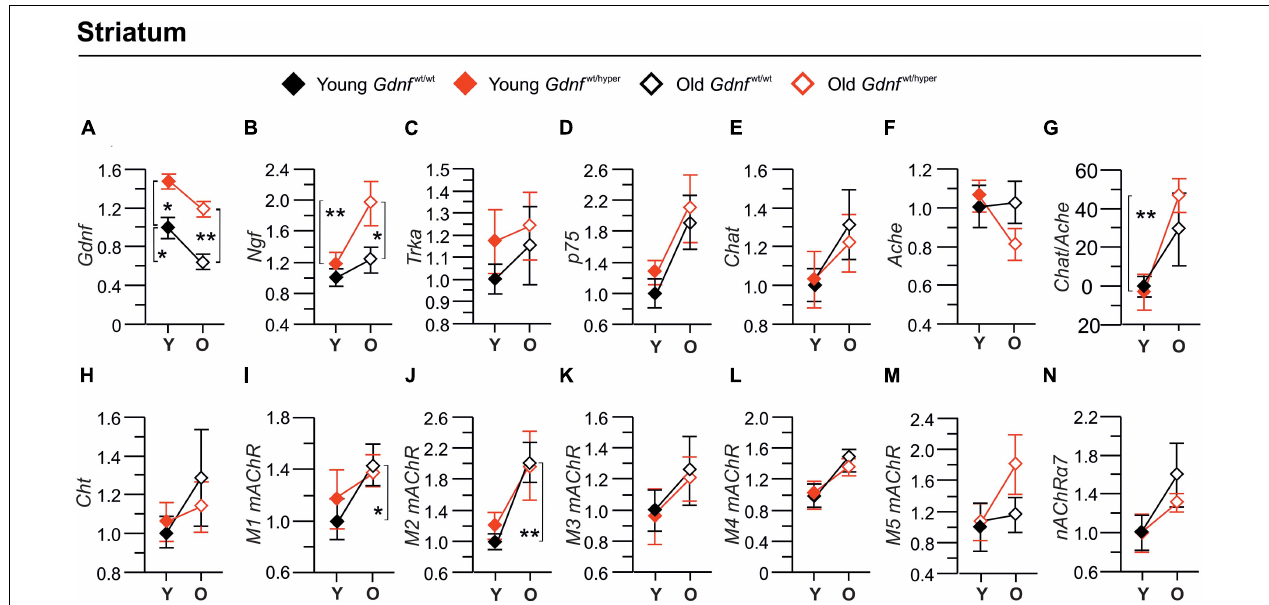
FIGURE 4 | Gene expression of the main cholinergic genes in striatum. Graphs (A–F,H–N) show the fold-changes in the gene expressions relative to the corresponding gene expression level in the striatum of the young Gdnf wt / wt mice. The gene expressions were measured by quantitative PCR. In panel (G) is shown percent changes in a Cholinergic index calculated based on the ratio between the gene expressions of Chat to Ache . n = 5 (young Gdnf wt / wt ), n = 6 (old Gdnf wt / wt ), n = 6 (young Gdnf wt / hyper ), n = 7 (old Gdnf wt / hyper ). Data are presented as mean folds-changes ± SEM. * p < 0.05; ** p < 0.01. Ache, acetylcholinesterase; Chat , choline acetyltransferase; Cht , choline transporter; Gdnf , glial cell line-derived neurotrophic factor; M1 mAChR, m1 muscarinic ACh receptor; M2 , m2 muscarinic ACh receptor; M3 mAChR, m3 muscarinic ACh receptor; M4 , m4 muscarinic ACh receptor; M5 , m5 muscarinic ACh receptor; p75 , p75 neurotrophin receptor; α 7-nAChR , alpha 7 nicotinic ACh receptor; Ngf , nerve growth factor; O, old; Trka , tropomyosin receptor kinase A; Y,